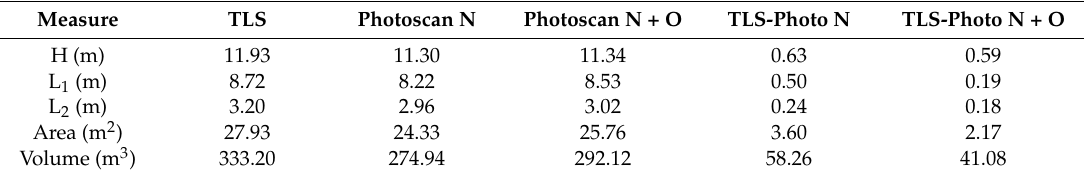
Table 10. Comparison between the measurements on the Photoscan and TLS.